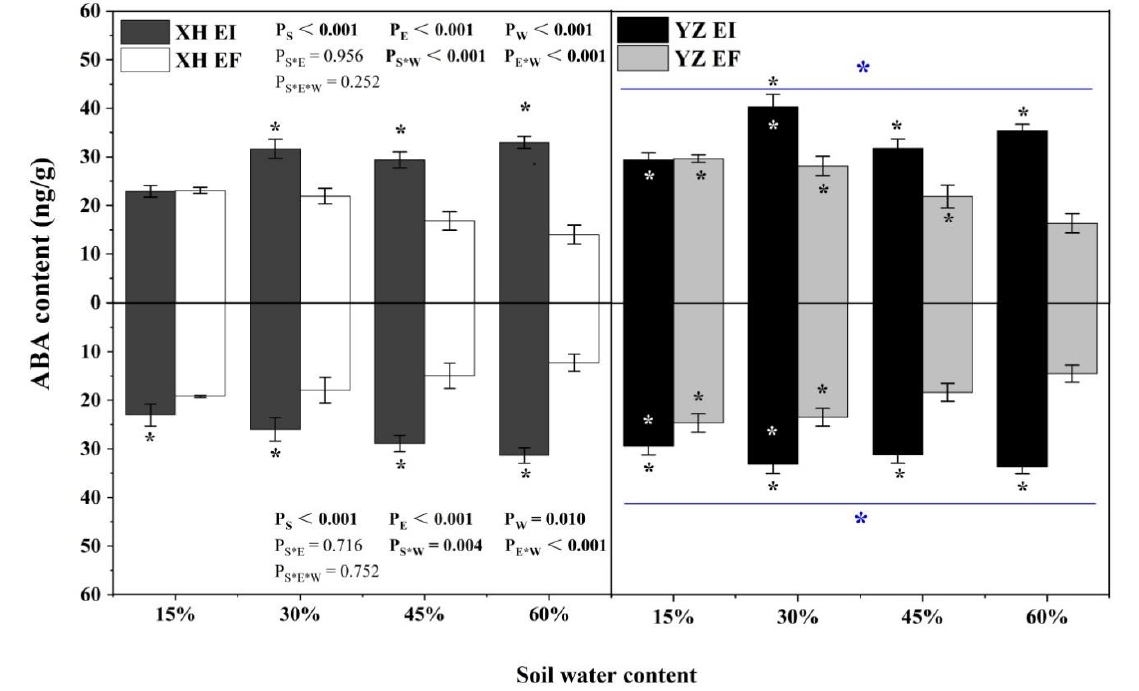
Figure 2. The ABA content of A. inebrians seedlings shoots and roots from XH(W) and YZ(D) seeds under various soil water content (ng/g). Upwards and downwards bars represent the value of shoot and root part, respectively. The asterisk (*) above/below error bars means significant difference ( p < 0.05) between EI and EF under the same soil water content. White/black * in the black/gray bars indicates significant difference ( p < 0.05) between Xiahe and Yuzhong maternal habitat type of EF/EI grasses. The blue * above/below full blue line indicates significant difference ( p < 0.05) between Xiahe and Yuzhong maternal habitat type.